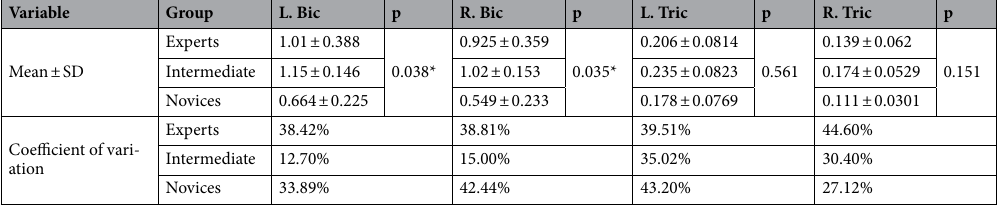
Table 1. Duration of muscle activation time during the free-throw [s] (mean ± standard deviations), in groups. * Statistical significance